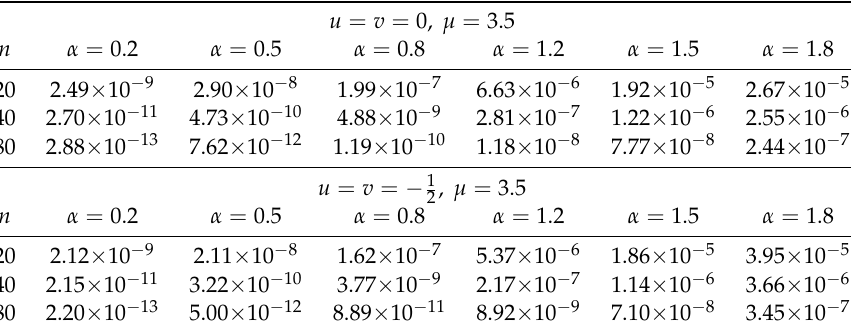
Table 8. The absolute errors for Example